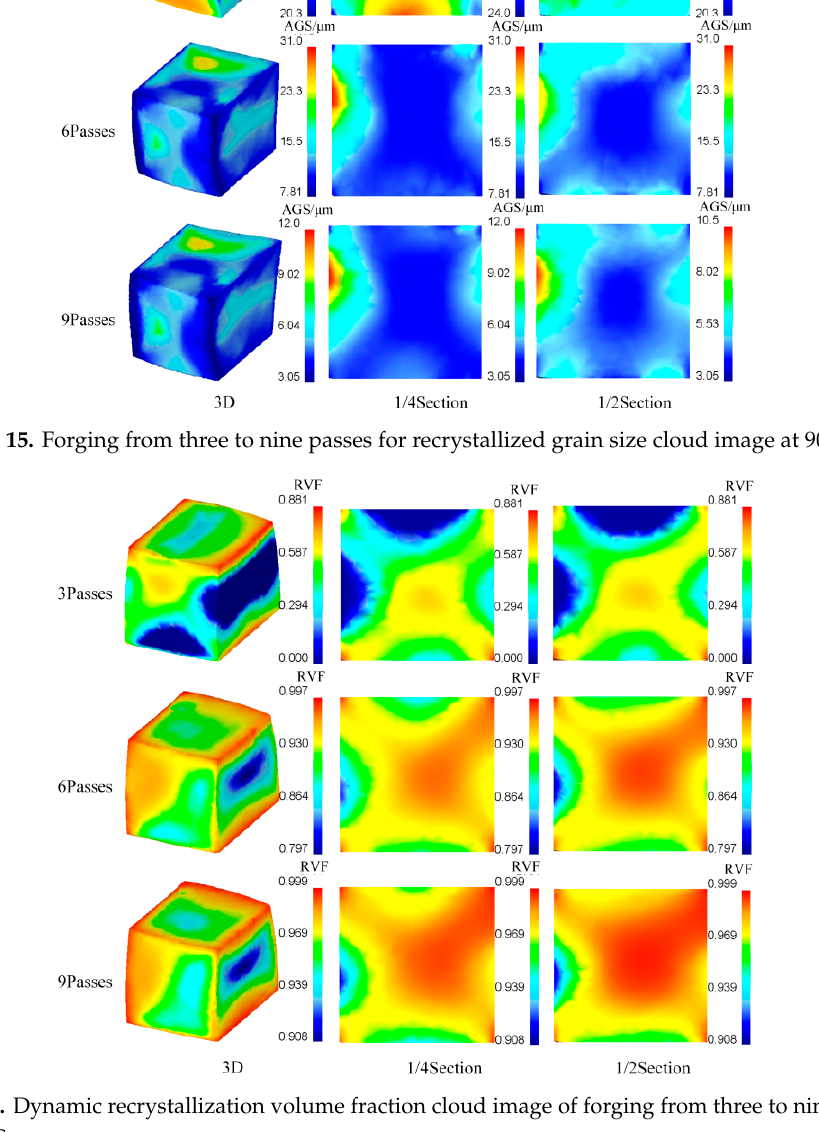
Figure 16. Dynamic recrystallization volume fraction cloud image of forging from three to nine passes at 1000 °C.